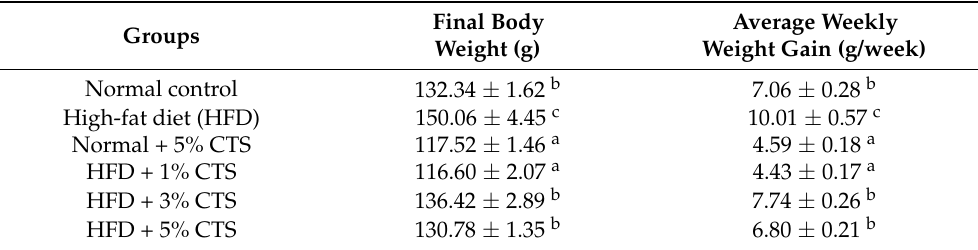
Table 2. Effect of chitosan (CTS) supplementation on final body weight and average weekly weight gain of rats fed with a high-fat diet